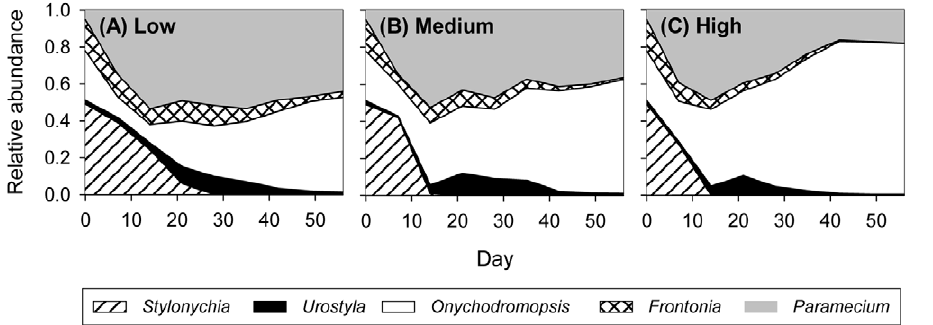
Figure 4. Relative metacommunity abundances of the five ciliate species. (A) low connectivity treatment, (B) medium connectivity treatment, and (C) high connectivity treatment.